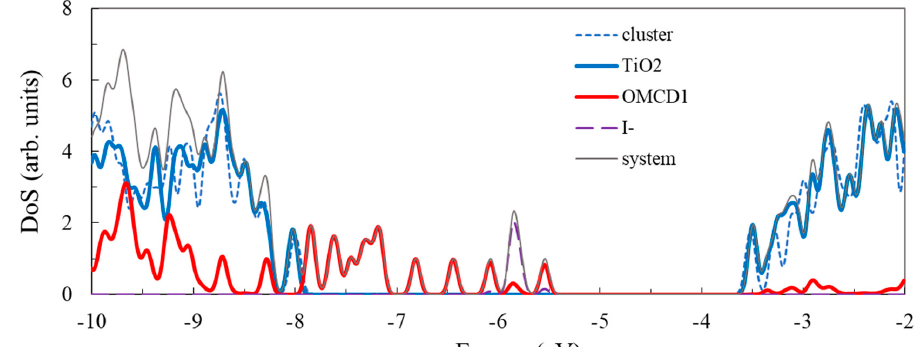
Figure 13. As in the case of the smaller adsorbed molecule, presented in the previous section, the contribution of the OMCD1 molecule to the density of states is more significant in the valence band and particularly in the gap, where the HOMO of the complex system is located. The HOMO level clearly has a dominant contribution from the adsorbed molecule, the orbital having a π nature. In contrast, the LUMO has most significant contribution from the oxide, the nature of the molecular orbital being determined by the d atomic orbitals of Ti. We note that in this case too, the HOMO and the LUMO are not pure, a small contribution being present from the cluster in the HOMO and from the molecule in the LUMO.